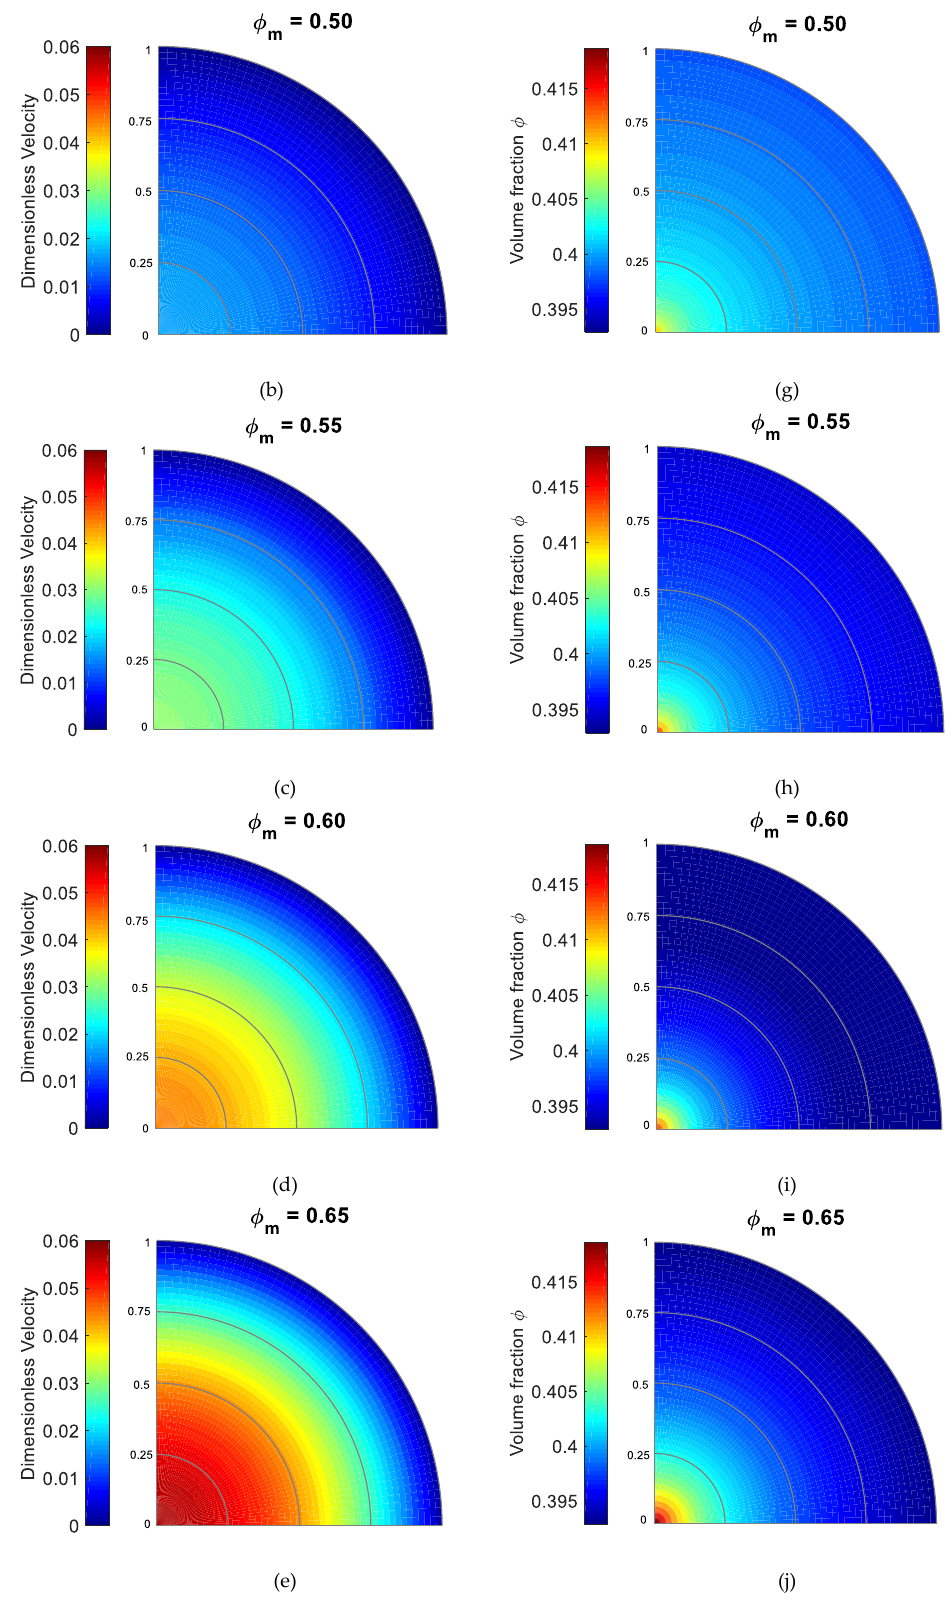
Figure 4. Distribution of the velocity for ( a ) φ m = 0.45; ( b ) φ m = 0.50; ( c ) φ m = 0.55; ( d ) φ m = 0.60; ( e ) φ m = 0.65; and the cement volume concentration for ( f ) φ m = 0.45; ( g ) φ m = 0.50; ( h ) φ m = 0.55; ( i ) φ m = 0.60; ( j ) φ m =